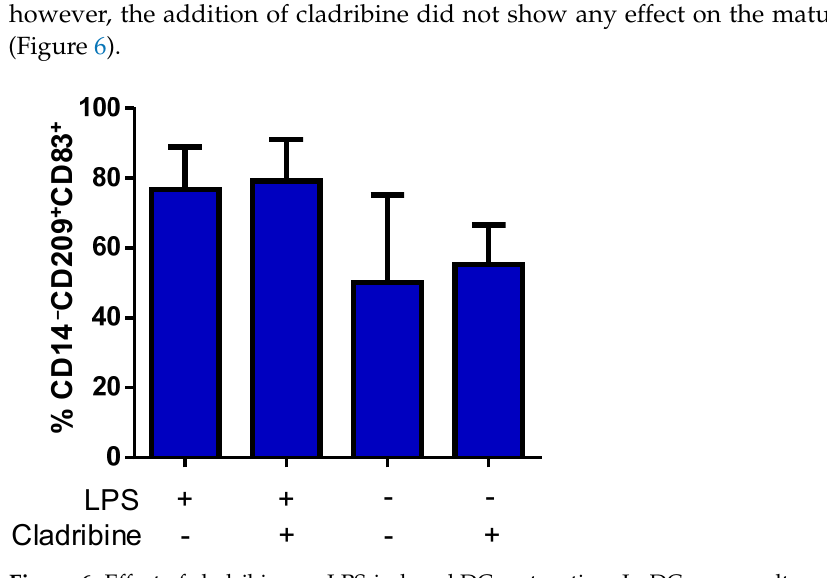
Figure 6. Effect of cladribine on LPS-induced DC maturation. ImDCs were cultured in the presence or absence of 100 ng/mL of LPS, and treated with no cladribine or 0.1 µ M cladribine for 24 h. Staining for the maturation (CD83), DCs (CD209) and monocyte (CD14) markers was performed, and alive cells were selected based on the staining with a viability dye. We quantified mDCs in the alive CD14 − CD83 + CD209 + cells by flow cytometry. The gating strategy for this experiment is shown in the Supplementary Figure S5. Mann–Whitney test or Student’s t -test were applied to compare the mean value of LPS + cladribine to a control mean (LPS group). Values represent mean ± SEM, ( N = 5). LPS: lipopolysaccharide.